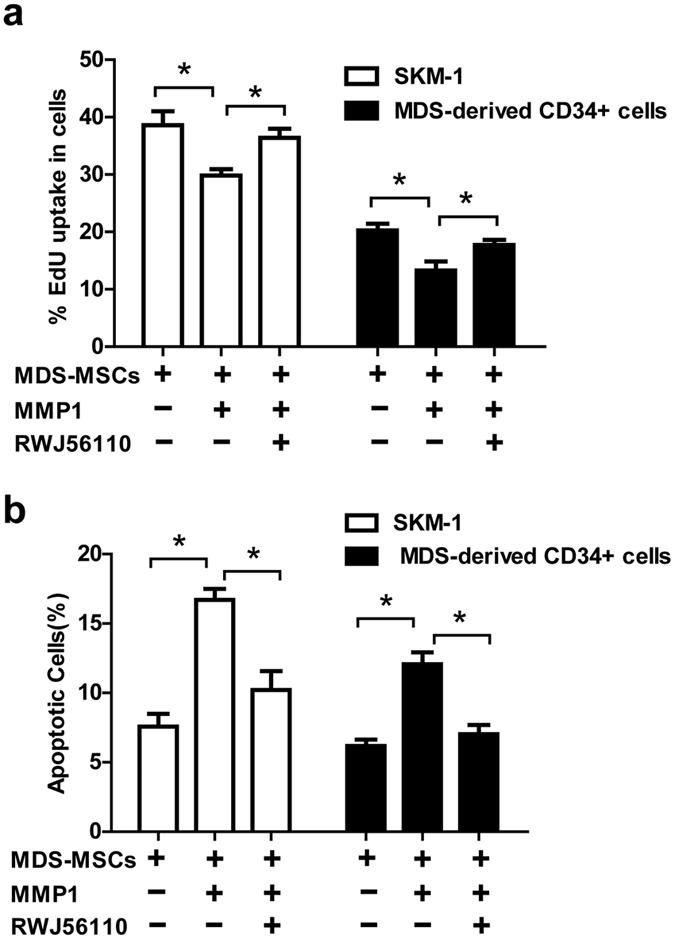
MMP1 affects proliferation and apoptosis of MDS cells through interaction with PAR1.In the MDS-MSC and MDS cells co-culture system, 1 nM exogenous activated MMP1 was added with or without pre-administration of RWJ56110 (5 μM). The percentage of proliferating MDS cells and apoptotic MDS cells was assessed by the EdU assay (a) and Annexin V/PI dual staining (b). (Data represent the mean ± SEM from at least three independent experiments. *P < 0.05).